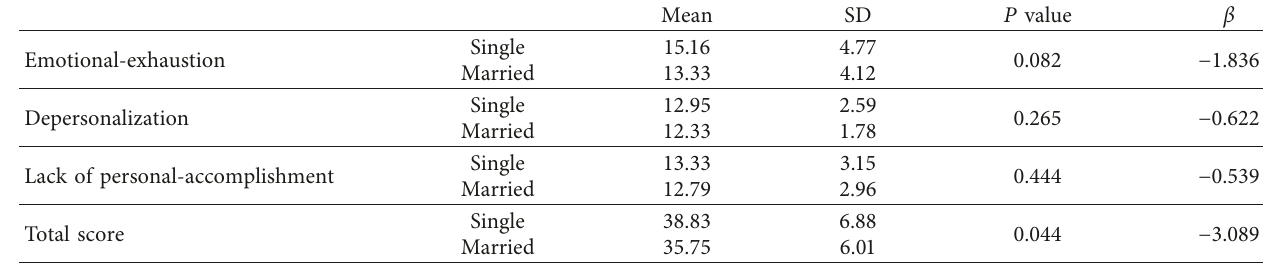
Table 4: Relationship between burnout dimensions and marital status in participants.